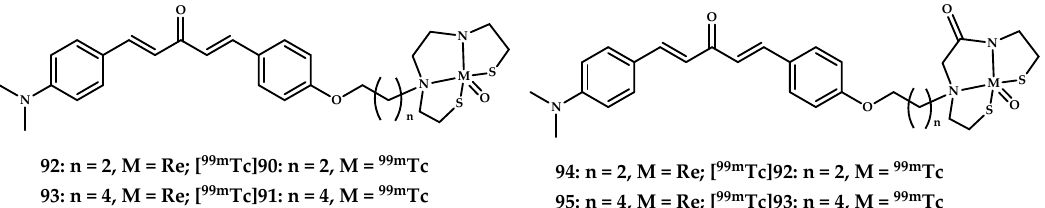
Figure 23. С oordination compounds Re/ 99m Tc 92–95 based on dibenzylideneacetone scaffolds with BAT ( 92, 93/[ 99m Tc]92, [ 99m Tc]93 ) and MAMA ( 94, 95/[ 99m Tc]94, [ 99m Tc]95 ) designed for SPECT imaging ( 92, 93 / [ 99m Tc]92, [ 99m Tc]93 ) and MAMA ( 94, 95 / [ 99m Tc]94, [ 99m Tc]95 ) designed for SPECT imaging of of A β plaques. A β